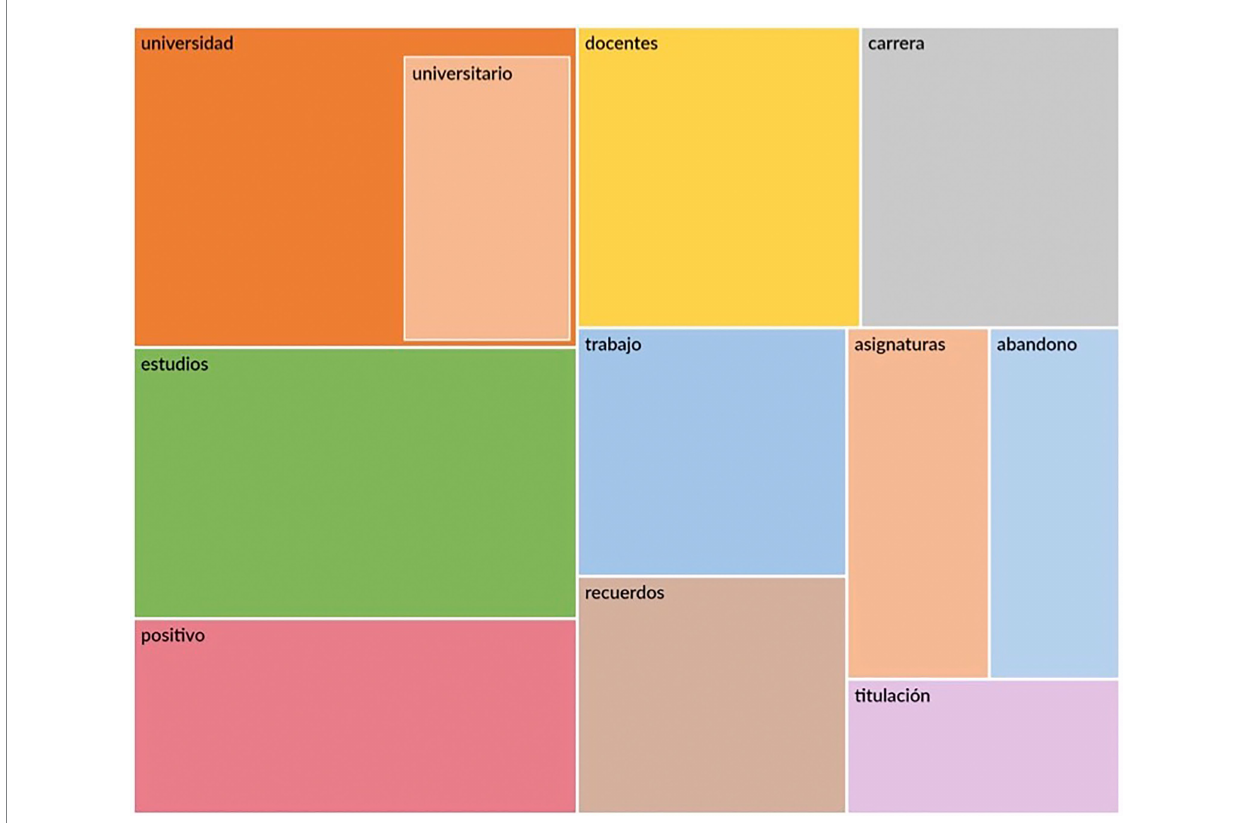
FIGURE 6 Representation of the concepts with the highest relative importance that make up the abandonment library. Caption (top to bottom-left to right): (A) universidad (University), (B) universitario (Undergraduate), (C) estudios (Studies), (D) positivo (Positive), (E) docentes (Teachers), (F) carrera (Career), (G) trabajo (Job), (H) asignaturas (subjects), (I) abandono (Dropout), (J) titulación (Grade).